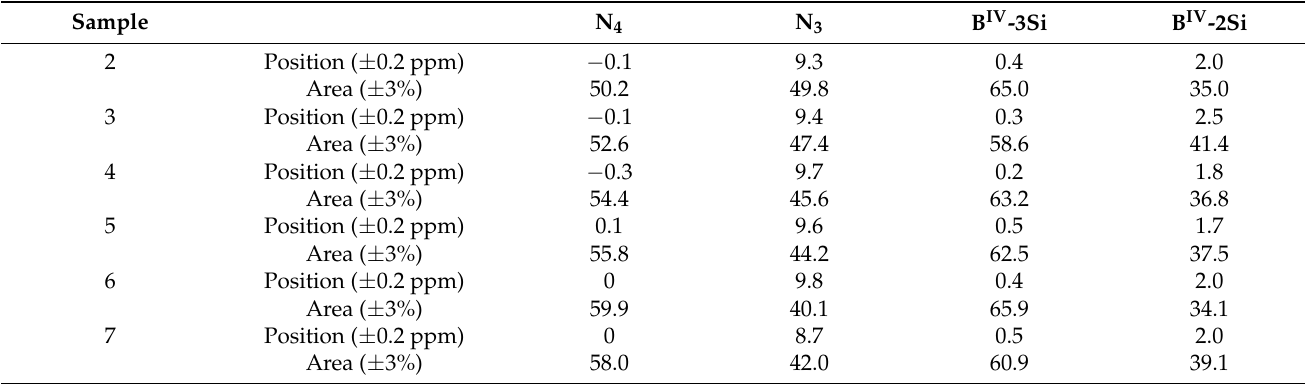
Table 3. Calculation results of quadrupolar model fitting of 11 B NMR spectra.